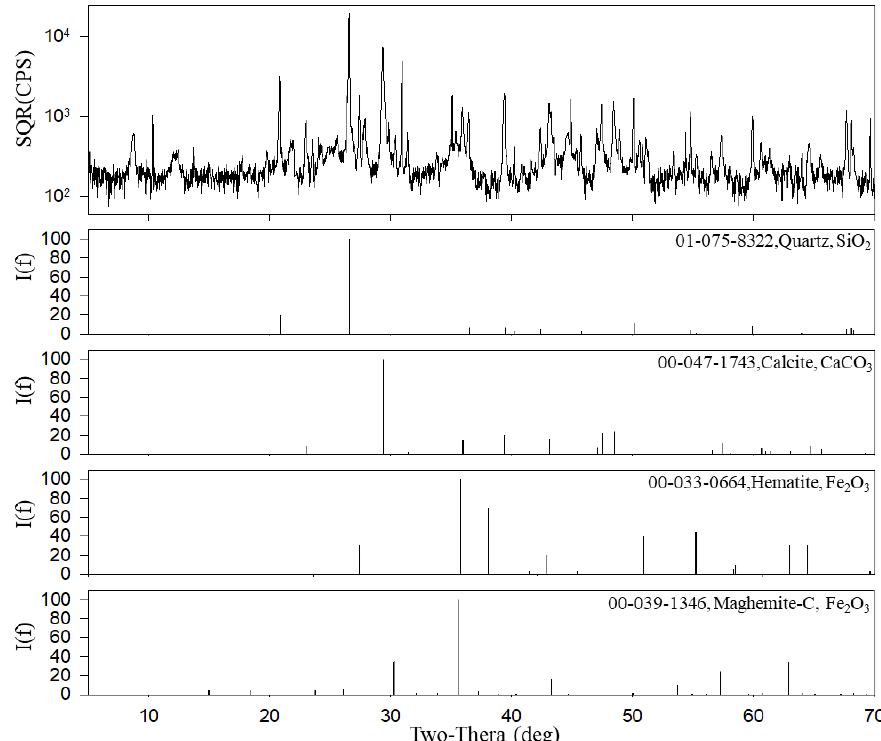
Figure 8. X-ray diffraction (XRD) patterns of PM in the subway tunnel at the S station.